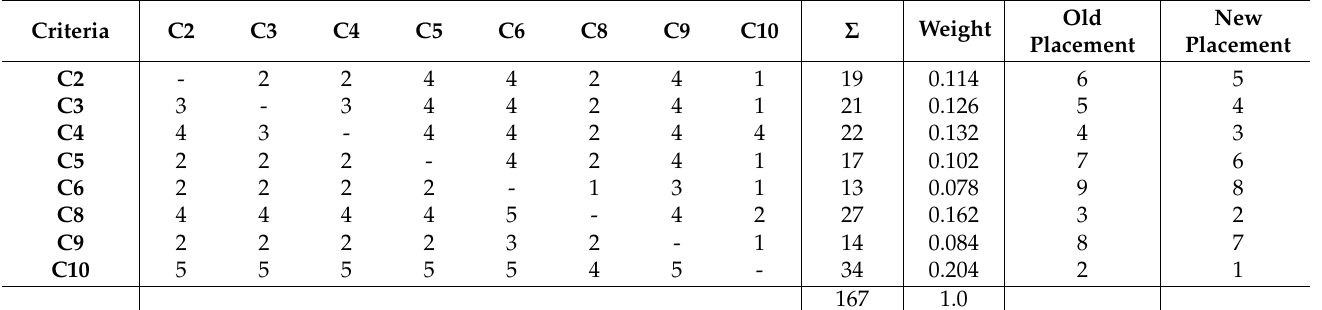
Table 9. Pairwise comparison as sensitivity analysis according to the “rank reversal” approach. The weighting and placement of the remaining criteria in relation to each other remains the same in relative